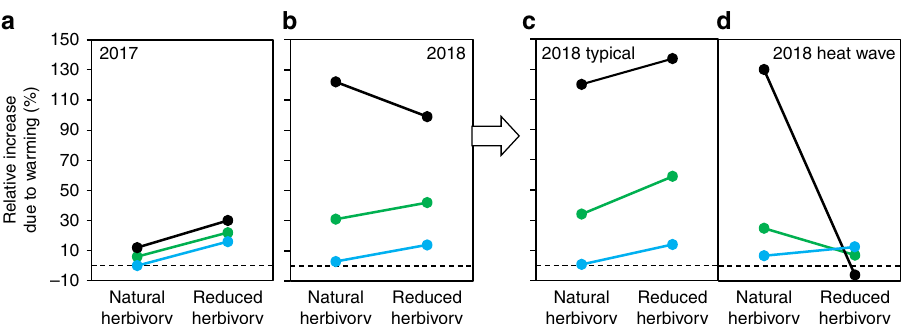
Fig. 4 Schematic illustrations of how herbivory modi fi ed the effects of warming on ecosystem CO 2 exchange. Year 2017 responses are shown as a overall means only while year 2018 responses are shown as both b overall means and split into two periods: c typical weather conditions and d a period of an extreme heat wave (pale yellow stripe in Figs. 1 and 3). The relative increase in gross primary production GPP 800 (green dots), net ecosystem exchange NEE 800 (black dots), and ecosystem respiration R e (blue dots) due to warming was higher when herbivore pressure was reduced in 2017 and in 2018 under typical weather conditions, but not during the 2018 heat wave. These responses suggest that plants with reduced herbivory bene fi ted more from warming (in terms of CO 2 fi xing) than plants with natural herbivory under typical humid conditions, but not under the heat wave, apparently because of being more susceptible to hydrological stress due to greater size (Fig. 2g) and higher water consumption (Fig.